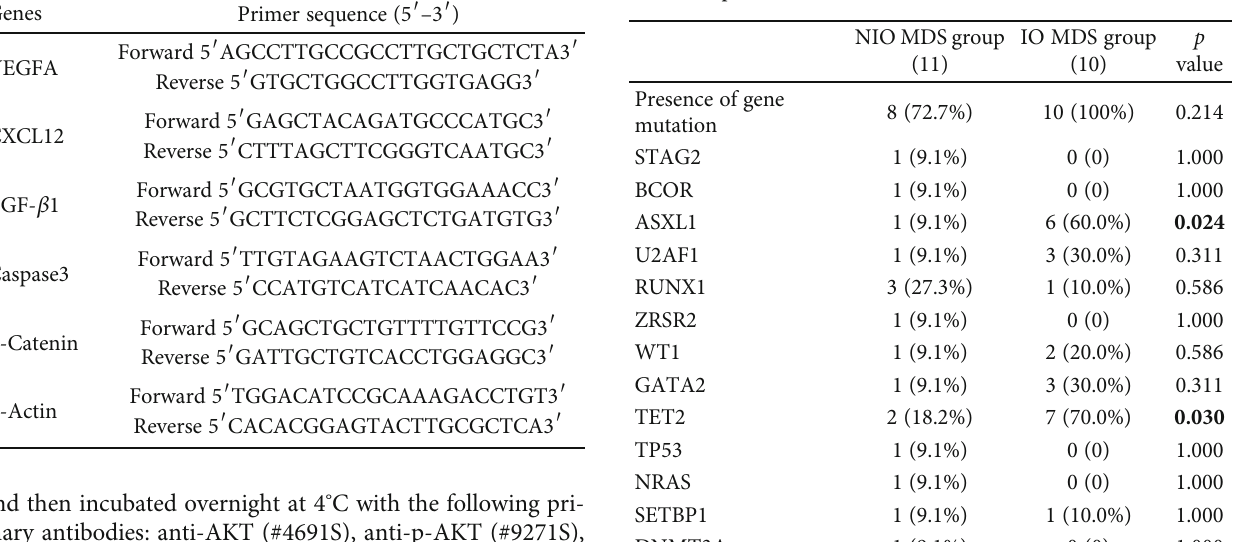
Table 3: Next generation sequencing of the intermediate or high- risk MDS